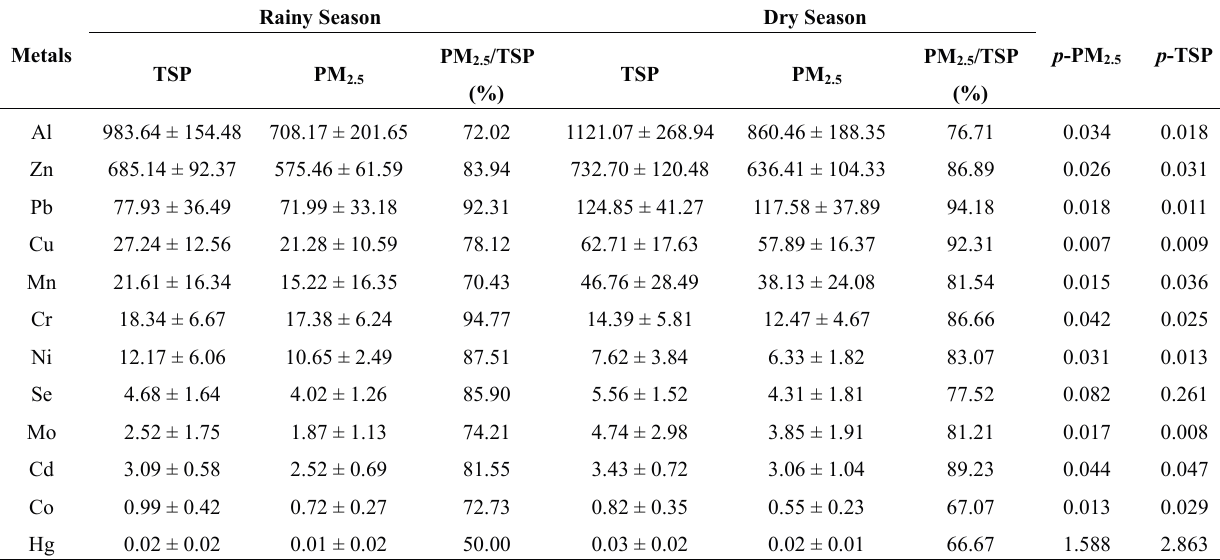
(ng·m − 3 ) in the rainy and Table 2. Metal concentrations (mean ± SD) in the TSP and PM 2.5 dry seasons. The values of p -PM and p -TSP values indicated the significant differences in 2.5 and TSP, respectively, between the rainy and dry the same metal in the PM 2.5